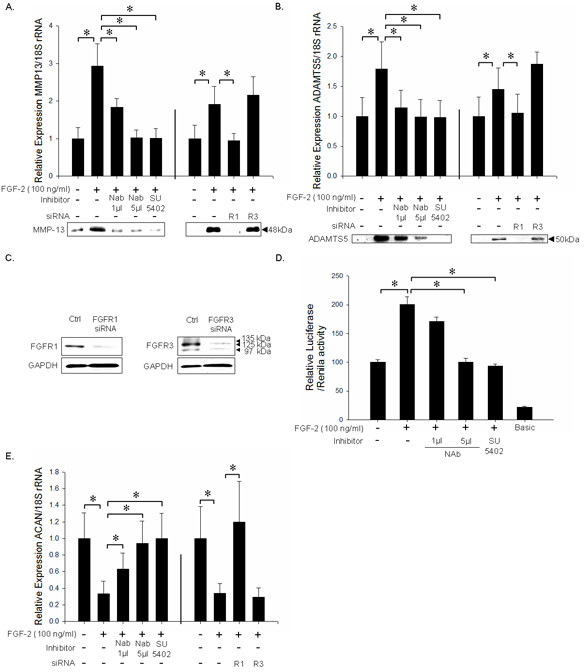
Effects mediated by FGFR1 upon FGF-2 binding. (A, B, E) Human articular chondrocytes in monolayer were treated with FGF-2 (100 ng/mL), in the absence or presence of FGFR1 neutralization antibody (1:1,000, 1:200) or SU5402 (5 μM), for 24 hours. In parallel, chondrocytes were transfected with siRNA targeting FGFR1 or FGFR3, and subjected to 24-hour FGF-2 (100 ng/mL) stimulation. Conditioned media were collected for immunoblotting analyses of matrix metalloproteinase-13 (MMP-13) and a disintegrin and metalloproteinase with a thrombospondin type 1 motif 5 (ADAMTS5). Total RNA was extracted for cDNA synthesis and qPCR quantification of gene expression. * P < 0.05. (C) Chondrocyte lysates were prepared 48 hours after siRNA transfection. The samples were resolved by SDS-PAGE, and immunoblotted for FGFR1 and FGFR3 protein expression. GAPDH was used as a loading control. (D) -1600MMP-13 Luciferase-promoter construct was transiently transfected into human articular chondrocytes. The transfected cells were pre-incubated with neutralizing antibody (1:1,000, 1:200) or 5 μM SU5402 for 1 hour, and then stimulated with FGF-2 (100 ng/mL) for 24 hours. The luciferase activity representing MMP-13 promoter activity was measured. A Renilla vector was co-transfected as an internal control for normalization. * P < 0.05. ADAMTS, a disintegrin and metalloproteinase with a thrombospondin type 1 motif; FGF, fibroblast growth factor; FGFR, FGF receptor; GAPDH, glyceraldehyde 3-phosphate dehydrogenase; MMP, matrix metalloproteinase; qPCR, quantative polymerase chain reaction; siRNA, small interfering RNA.